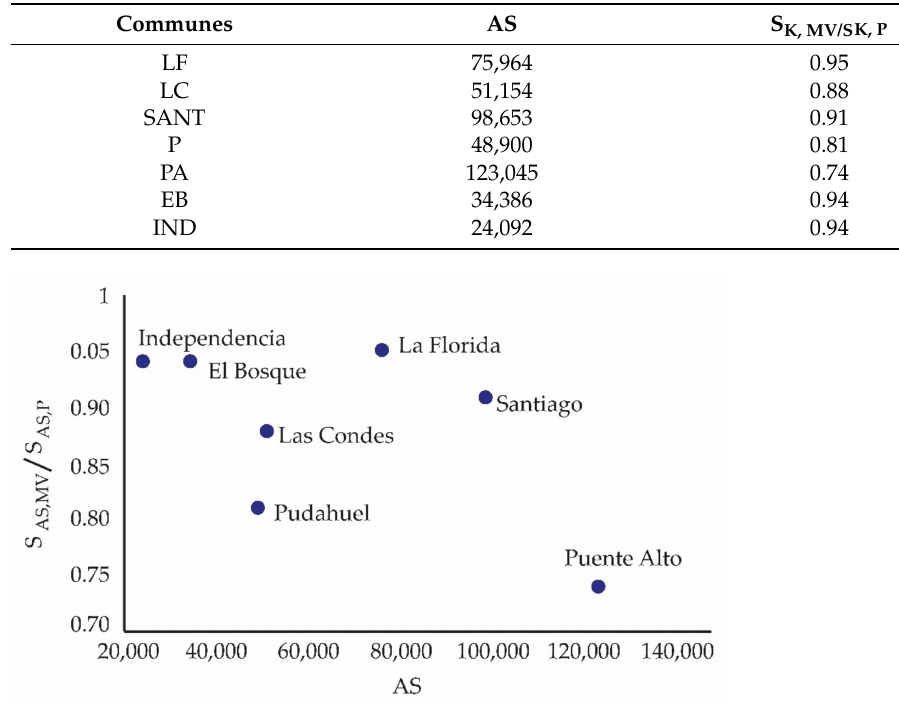
Table 4. Ratio between the entropies of accumulated patients/meteorological variables and the entropies of accumulated patients/pollutants and the accumulated sick people.